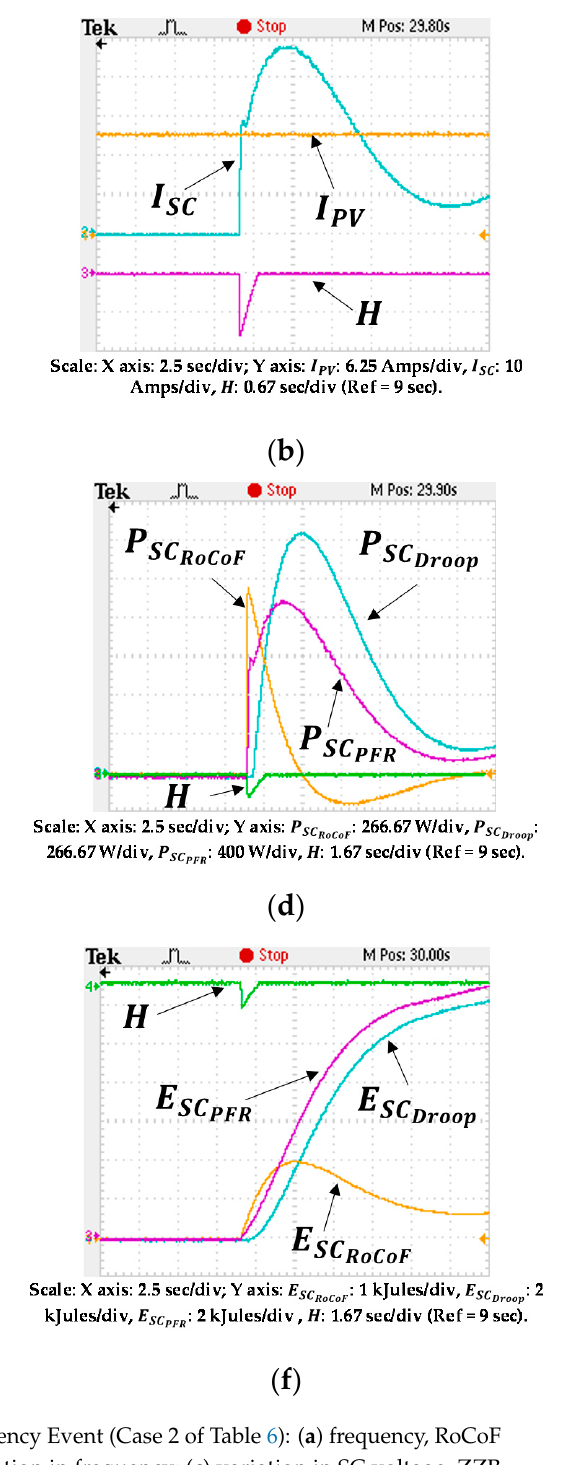
Figure 26. OPAL-RT RTS results for an example case of an Under-Frequency Event (Case 2 of Table 6): ( a ) frequency, RoCoF and Inertia constant profiles; ( b ) PV and SC currents subjected to variation in frequency; ( c ) variation in SC voltage, ZZB voltage and the Voltage gain of ZZB; ( d ) power profiles for the SC corresponding to RoCoF, Droop and PFR; ( e ) PV, SC and grid power profiles; ( f ) energy profiles for the SC corresponding to RoCoF, Droop and PFR.